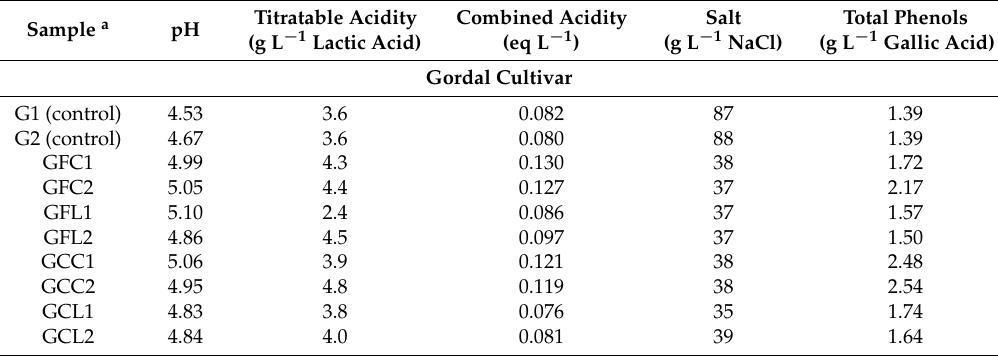
Table 1. The physicochemical analysis of olive brines after 11 months of